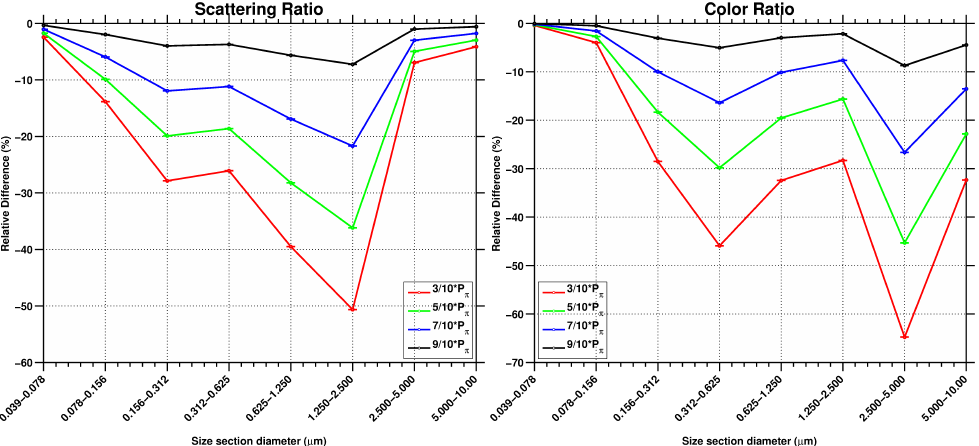
Fig. 6. Differences in the simulated attenuated scattering ratio (left) and color ratio (right) per size section as a function of the backscattering phase function value.